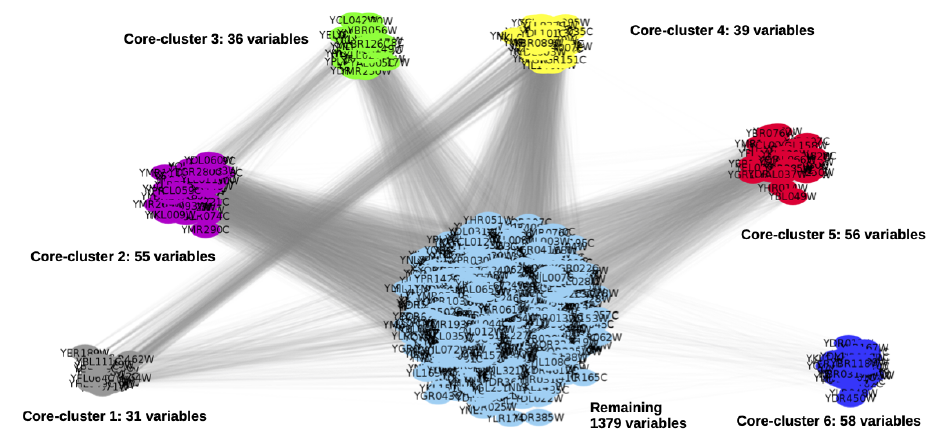
Figure 2. CORE-clusters obtained using Algorithm 2 on the yeast dataset of [33] and the granularity coefficient τ = 30. CORE-clusters containing 30 to 59 variables are then